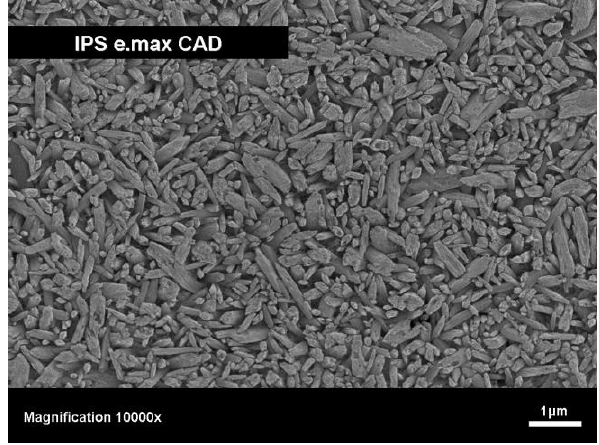
Figure 3. SEM image of the microstructure of a lithium disilicate-type glass-ceramic